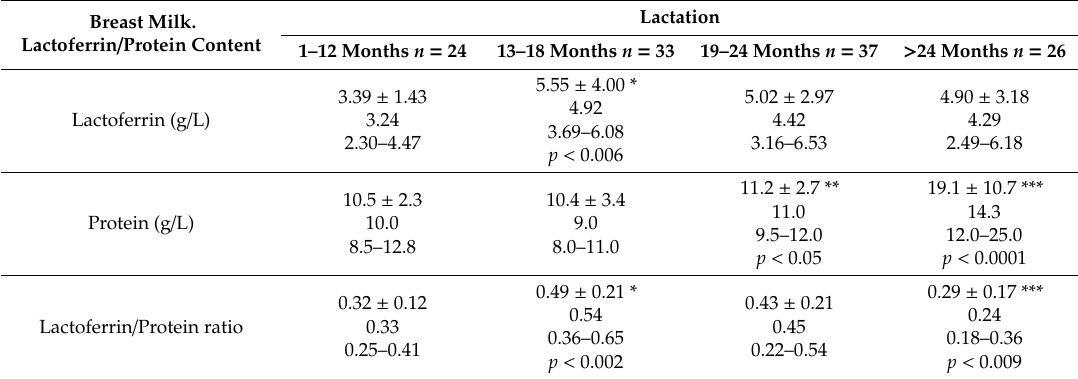
Table 2. Lactoferrin and protein concentrations in breast milk during prolonged lactation. Breast Milk. Lactoferrin / Protein Content